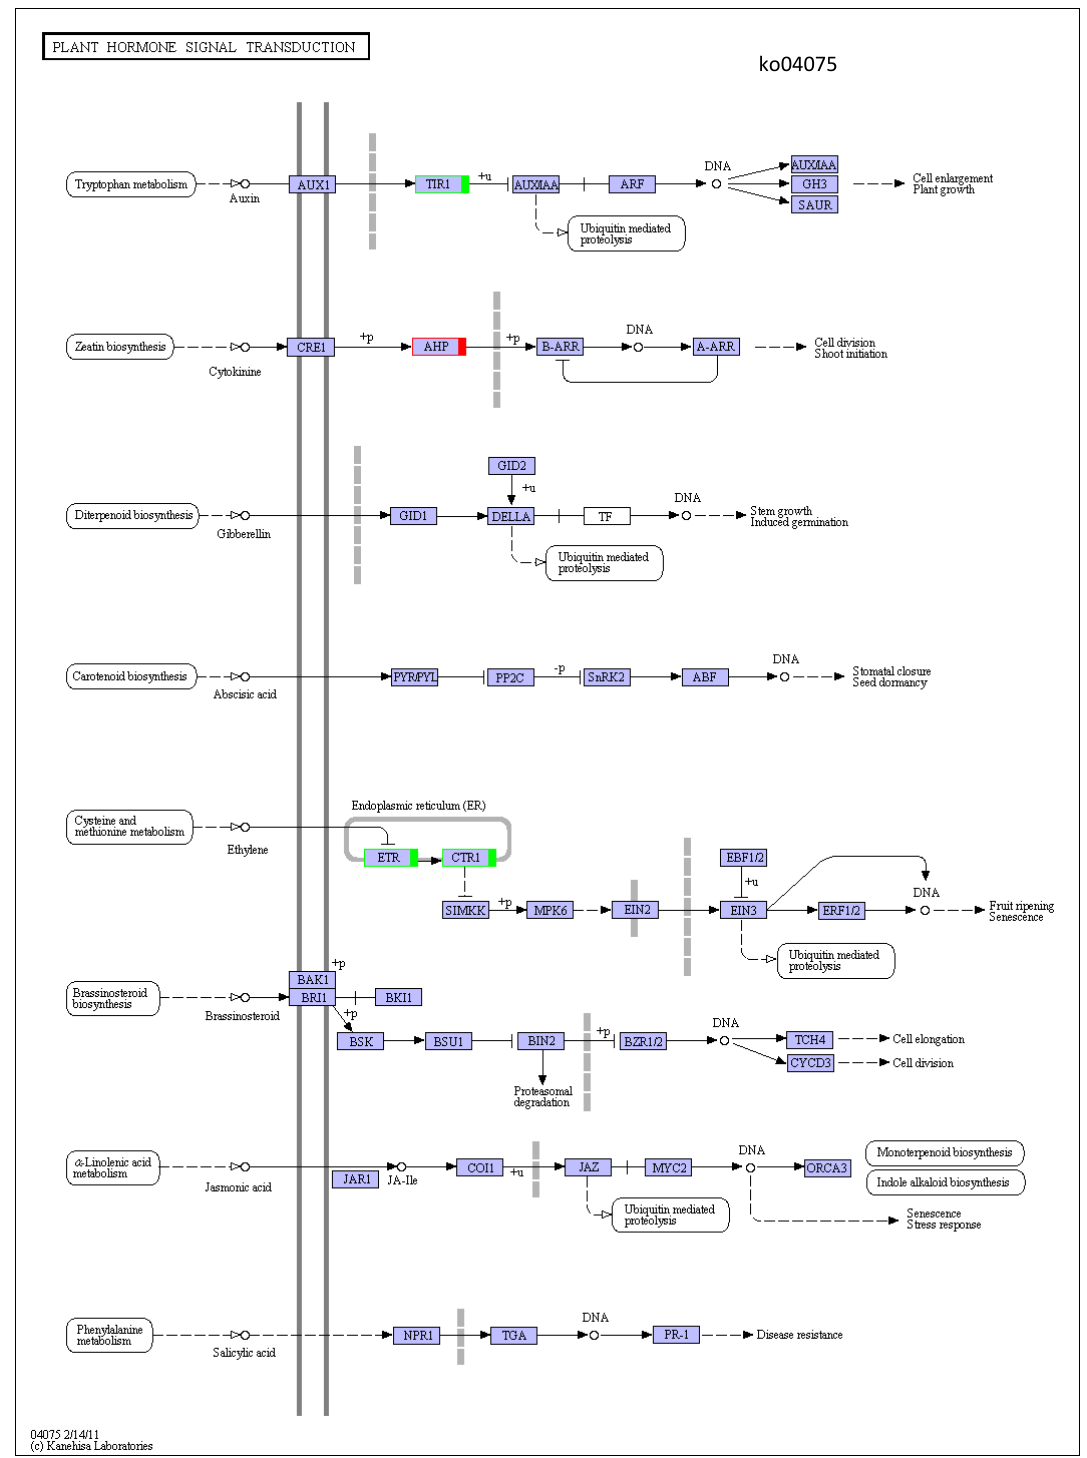
Figure 5. Signal transduction of plant hormones. Note: Red was up-regulated and green was down-regulated.